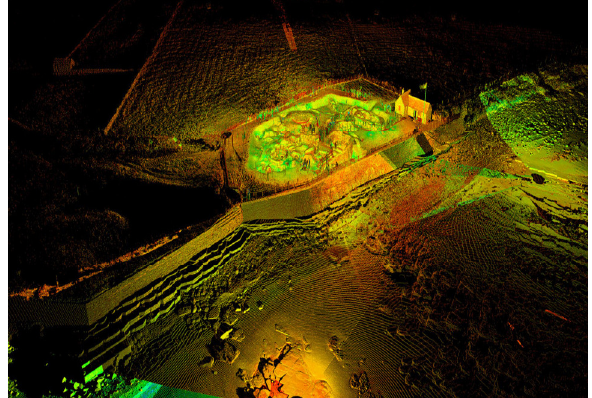
Figure 5. Model from airborne LiDAR data showing site and coastal defenses at Skara Brae © CDDV 2011. Figure 3. Sea wall defences visible in TLS data from Skara Brae, as recorded from the shoreline and coloured by intensity values © CDDV 2010.